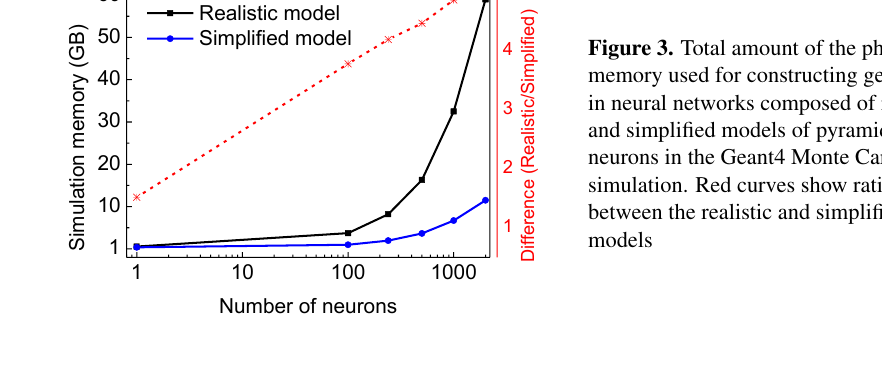
Figure 3. Total amount of the physical memory used for constructing geometry in neural networks composed of realistic and simplified models of pyramidal neurons in the Geant4 Monte Carlo simulation. Red curves show ratio between the realistic and simplified